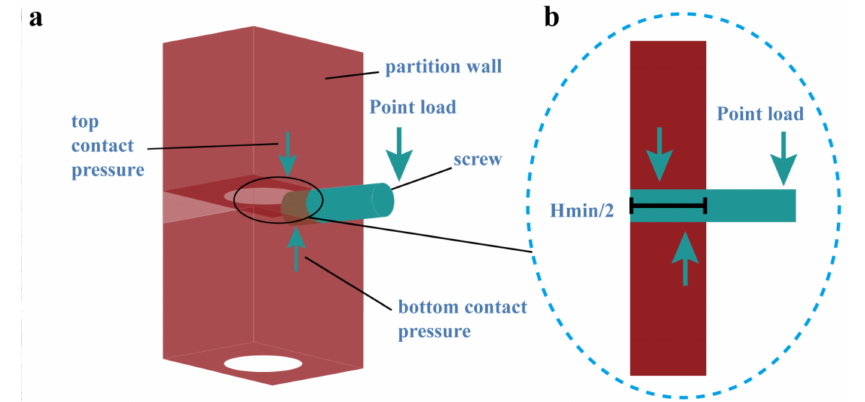
Figure 5. Finite element model for the contact of a screw and the wall during hanging: ( a ) screw located at the most disadvantageous position (at location H min ); and, ( b ) equilibrium of the contact force and the external